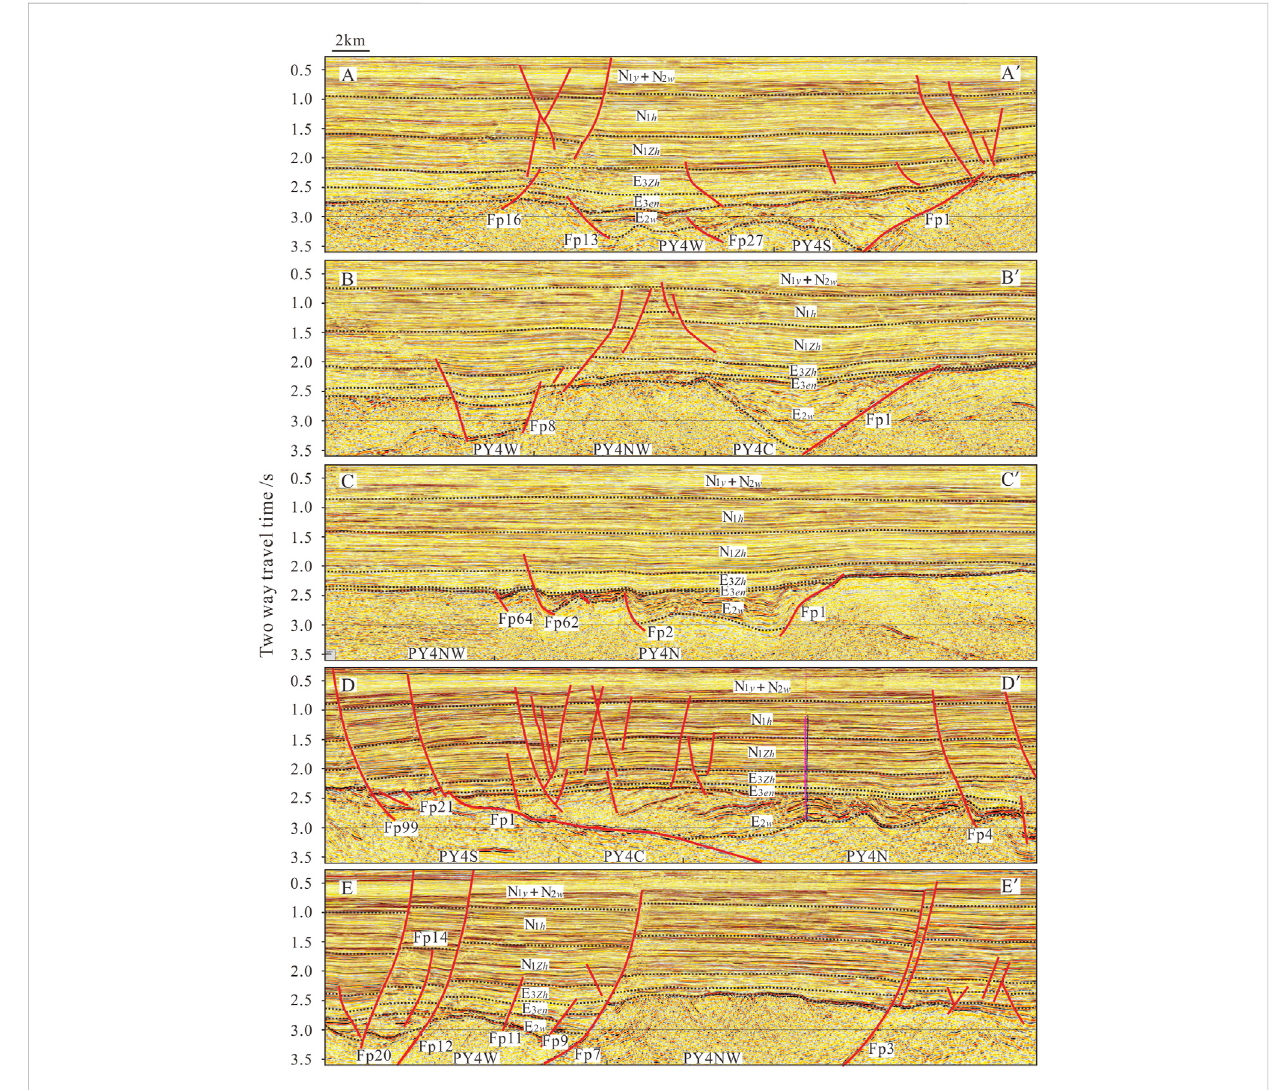
FIGURE 5 Seismic pro fi les of the Panyu 4 Sag (for section locations, see Figure 1C). AA ’ , BB ’ , CC ’ , DD ’ , EE ’ - Seismic line; PY4S - Southern sub-sag; PY4N - Northern sub-sag; PY4C - Central sub-sag; PY4W - Western sub-sag; PY4NW - Northwestern sub-sag; E 2 w - Wenchang Formation of Eocene; E 3 en - Enping Formation of later Eocene and early Oligocene; E 3 Zh - Zhuhai Formation of Oligocene; N 1 Zh , N 1 h , N 1 y , respectively, denote the Zhujiang, Hanjiang, Yuehai Formations of Miocene; N 2 w - Wanshan Formation of Pliocene.